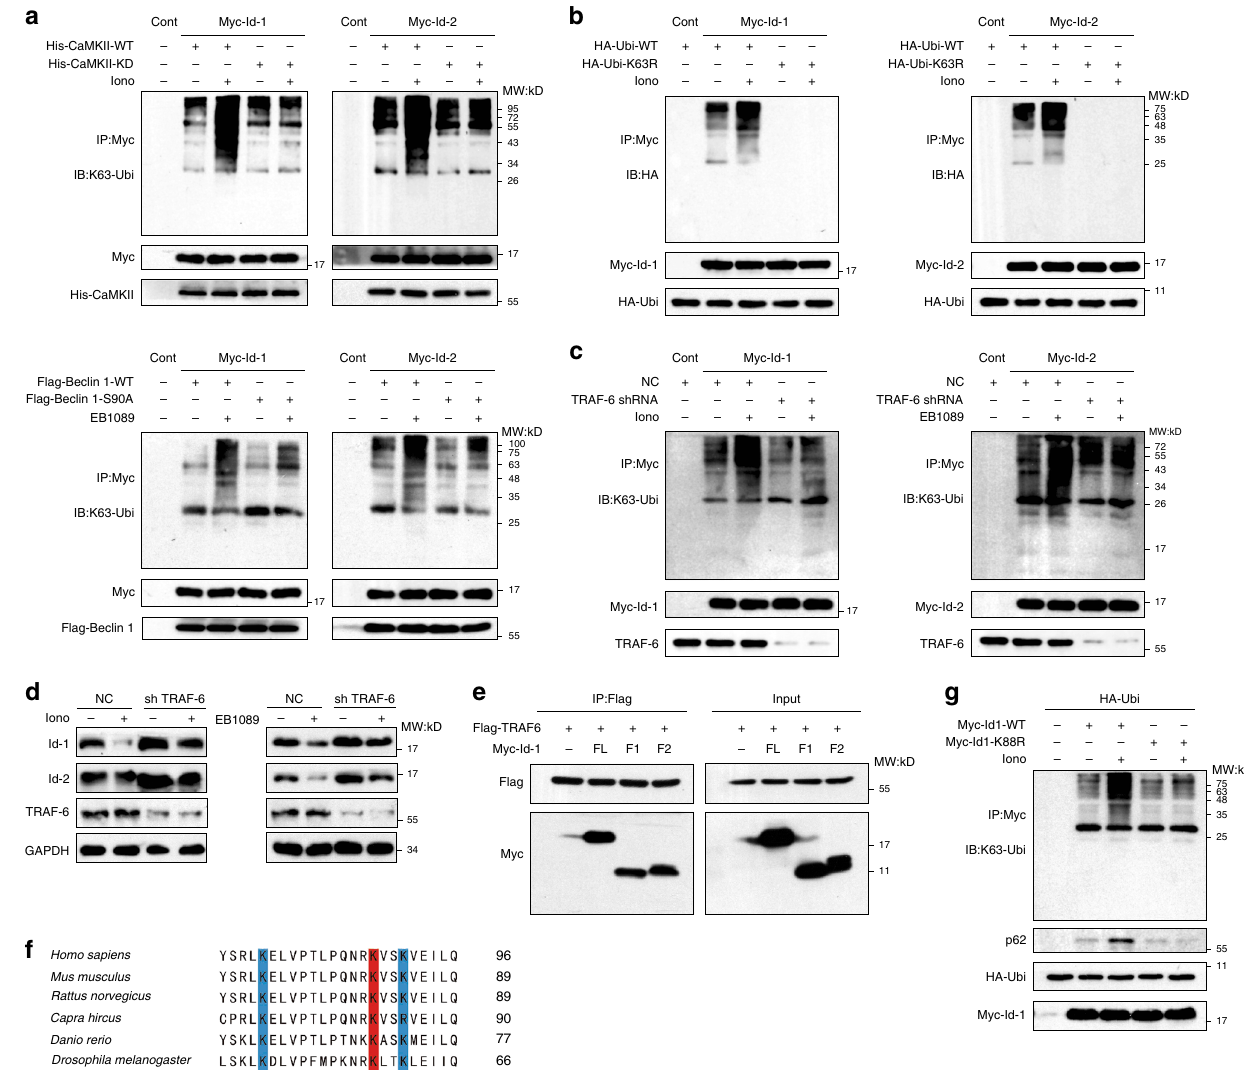
Fig. 6 TRAF-6 induced the K63-linked ubiquitination of Id-1 at the K88 residue. a CaMKII and phosphorylation of Beclin 1 Ser90 are required for K63 ubiquitination of Ids. HEK293T cells were transiently co-transfected with the indicated plasmids, treated with 6 μ M ionomycin for 24 h, and then incubated with 100 nM Baf A1 for 4 h. The immunoprecipitated Myc-Ids was subjected to anti-K63-ubiquitin western blot. b Id-1 and Id-2 undergoes K63 ubiquitination. HEK293T cells were transiently transfected with HA-Ubi or HA-Ubi-K63R plasmids, treated with 6 μ M ionomycin or 100 nM EB1089 for 24 h, and then incubated with 100 nM Baf A1 for 4 h. The immunoprecipitated Myc-Id-1/2 was subjected to anti-HA western blot. c TRAF-6 is required for the K63-ubiquitination of Id-1/2. HEK293T cells were transfected with the indicated plasmids for 24 h, incubated with 6 μ M ionomycin or 100 nM EB1089 for 24 h, and then treated with Baf A1 for 4 h. The immunoprecipitated Myc-Id-1/2 was subjected to anti-HA western blot. d TRAF-6 is required for the degradation of Id-1/2. HEK293T cells were transfected for 24 h with the negative control (NC) or TRAF-6 shRNA and then incubated for 24 h with 6 μ M ionomycin or 100 nM EB1089. The cell lysates were then analyzed by western blot. e The bHLH domain of Id-1 was required for its interaction with TRAF-6. HEK293T cells were transiently transfected with the indicated plasmids for 24 h and then treated with 6 μ M ionomycin for 24 h and 100 nM Baf A1 for 2 h before lysis. The whole-cell extracts were subjected to western blotting using the indicated antibodies after immunoprecipitation. f The lysine88 residues in the bHLH domain of Id-1 is more conserved during evolution (indicated with a red background and the other two with a blue background). g The K88 residue of Id-1 was necessary to the K63-linked ubiquitination of Id-1 induced by ionomycin. SK-N-SH cells were transiently co-transfected with plasmids encoding Myc-Id-1-WT or K88R and plasmid with HA-Ubiquitin, then treated with 6 μ M ionomycin for 24 h, and with Baf A1 for 4 h. The cell lysates were then analyzed by western blot after the Supplementary Figs. 3d – f, 4a – d showed that knockdown/inhibi- in the current study was marginal (Supplementary Fig. 3c). This tion of MK2/3/5 or p38 failed to impact the high level of Beclin 1 discrepancy may be due to the different cell lines and different phosphorylation and autophagy in normal or ionomycin-induced conditions utilized in these studies. condition. Which indicated that MKs did not function during the ionomycin-induced autophagy. Also it has been reported that the Ca 2+ /CaMKKbeta/AMPK/mTOR pathway activates autophagy in response to ionomycin 32 , AMPK activation or mTOR inhibition